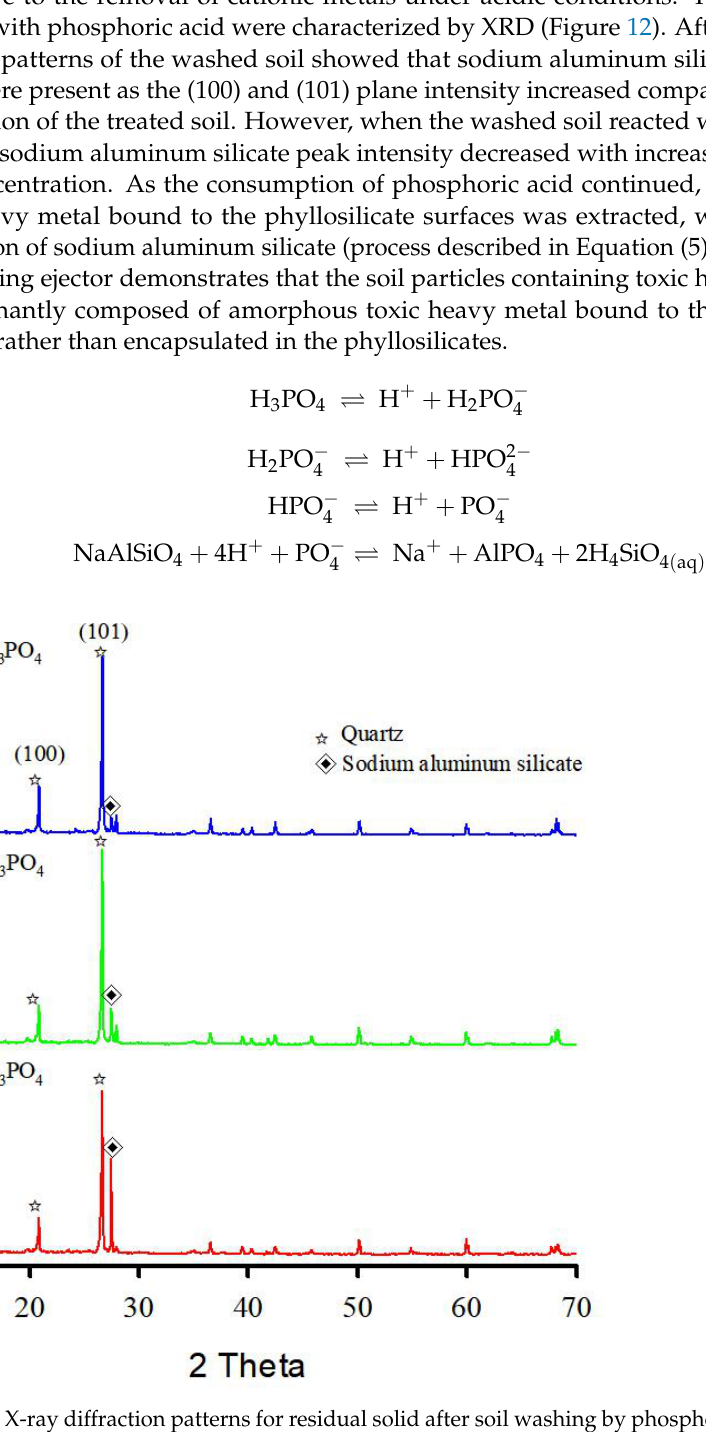
Figure 12. X-ray diffraction patterns for residual solid after soil washing by phosphoric acid (H 3 PO 4 ).